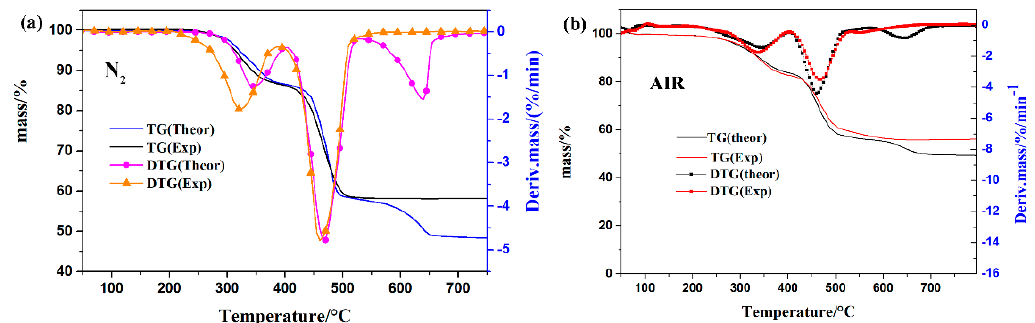
Figure 9. Experimental and calculated TG and DTG curves of ceramifiable EVA5 composites under nitrogen and air atmosphere.